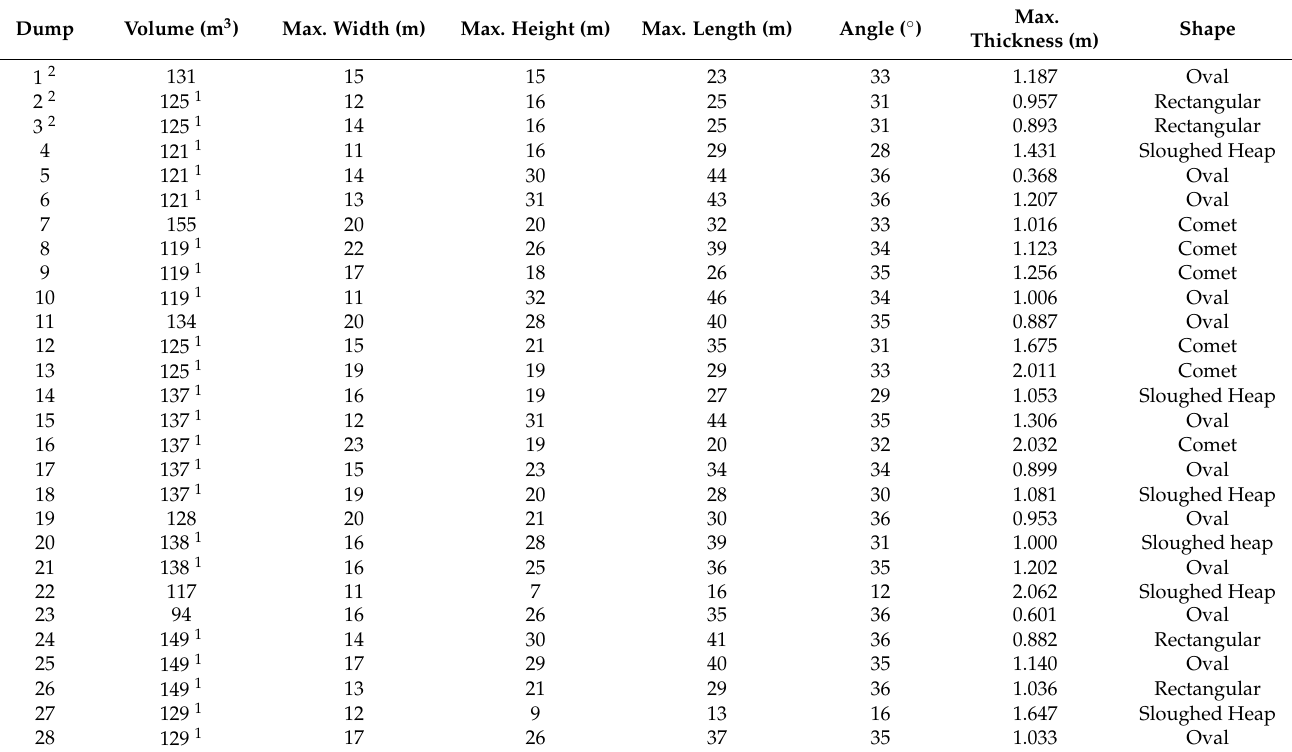
Table 5. Summary of Classification Data for All Dump Profiles.